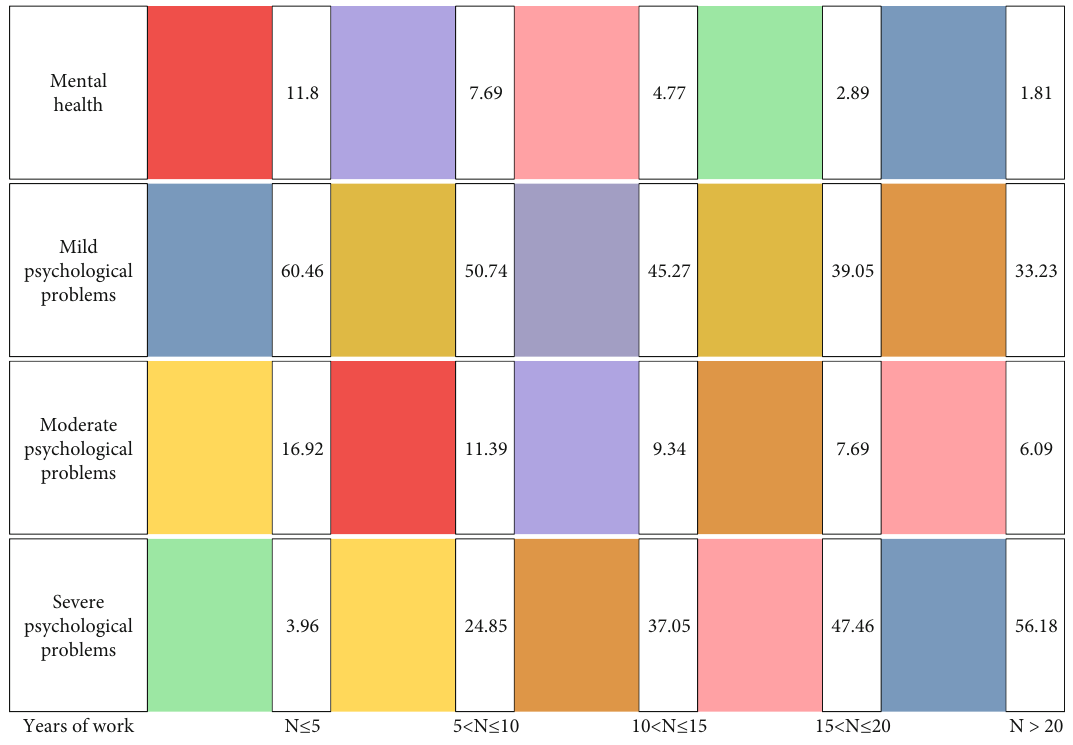
Figure 3: Comparison of teachers ’ mental health status with di ff erent working years.